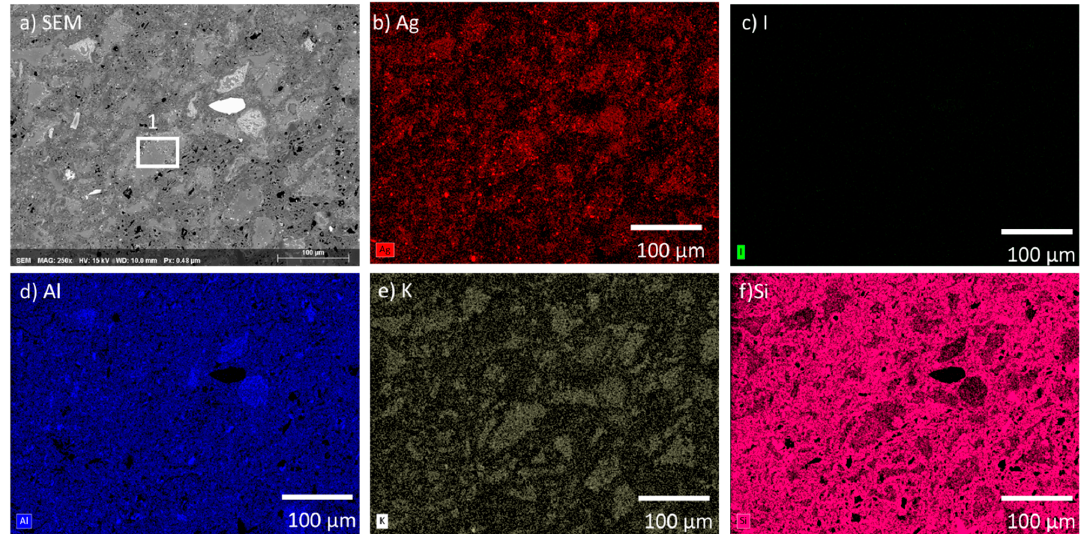
Figure 2. Microstructure of the AgZ 1-3 sample shown by: ( a ) SEM micrograph; and the corresponding EDS maps of: ( b ) Ag; ( c ) I; ( d ) Al; ( e ) K; and ( f ) Si. The large white inclusion in ( a ) is made of Zr and S whose origin are not known. The white box marked “1” is the location where an EDS spot analysis was performed and listed in Table 3. Table 3. Composition of the features highlighted in the SEM images in Figures 2a and 3a determined with EDS spot analysis.